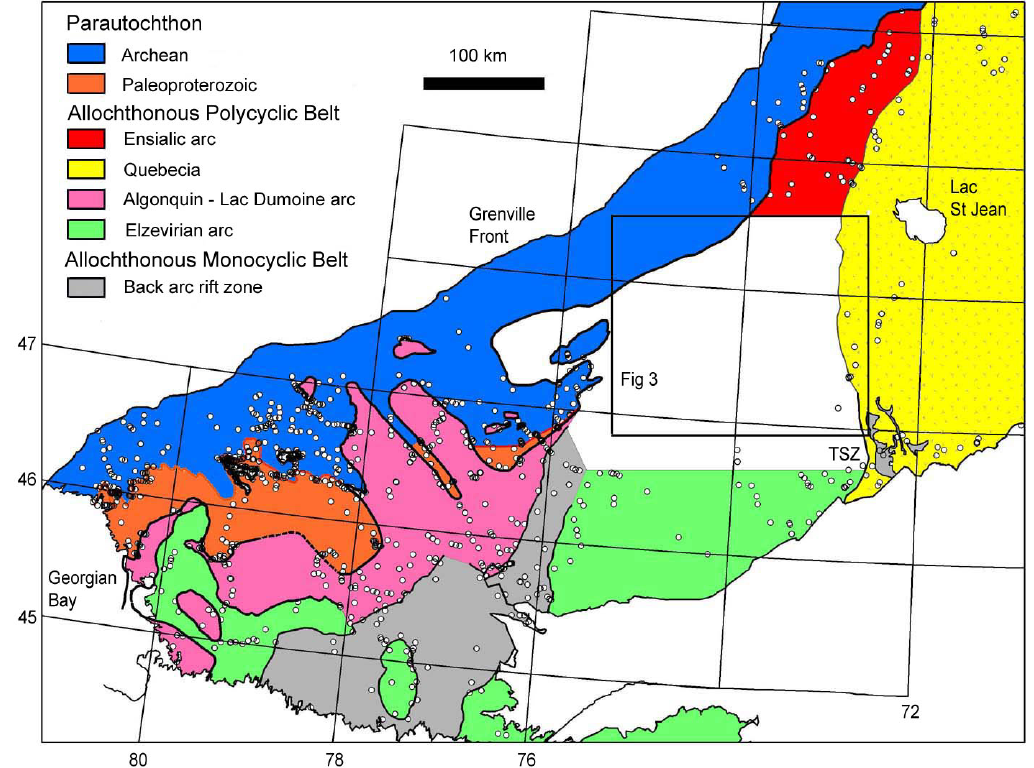
Figure 2. Map of the western Grenville Province showing the present study area (boxed), falling in a sampling gap between the established geological blocks and terranes of the Central and the SW Grenville Province. TSZ = Tawachiche Shear Zone. White = not yet